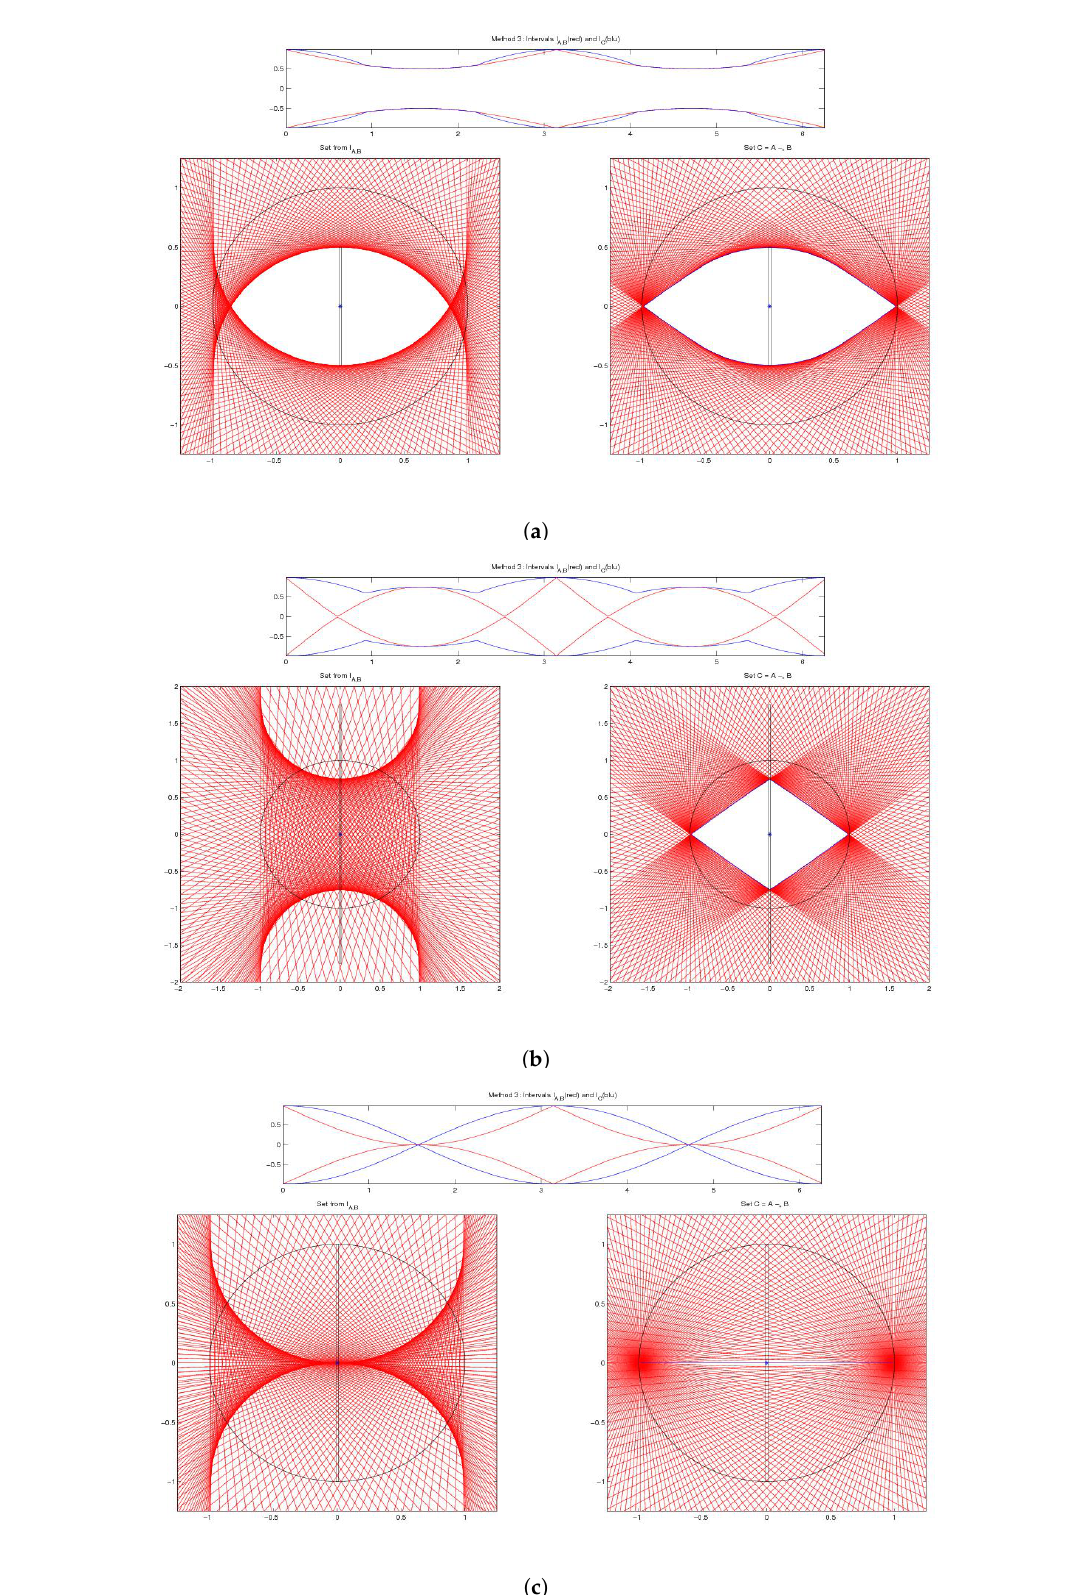
Figure 2. Example 2. g ∗ -difference C ∗ = A (cid:9) ∗ B a , µ for a = 0.01 and ( a ) top: µ = 0.5, ( b ) middle: µ = 1.25, ( c ) bottom: µ =